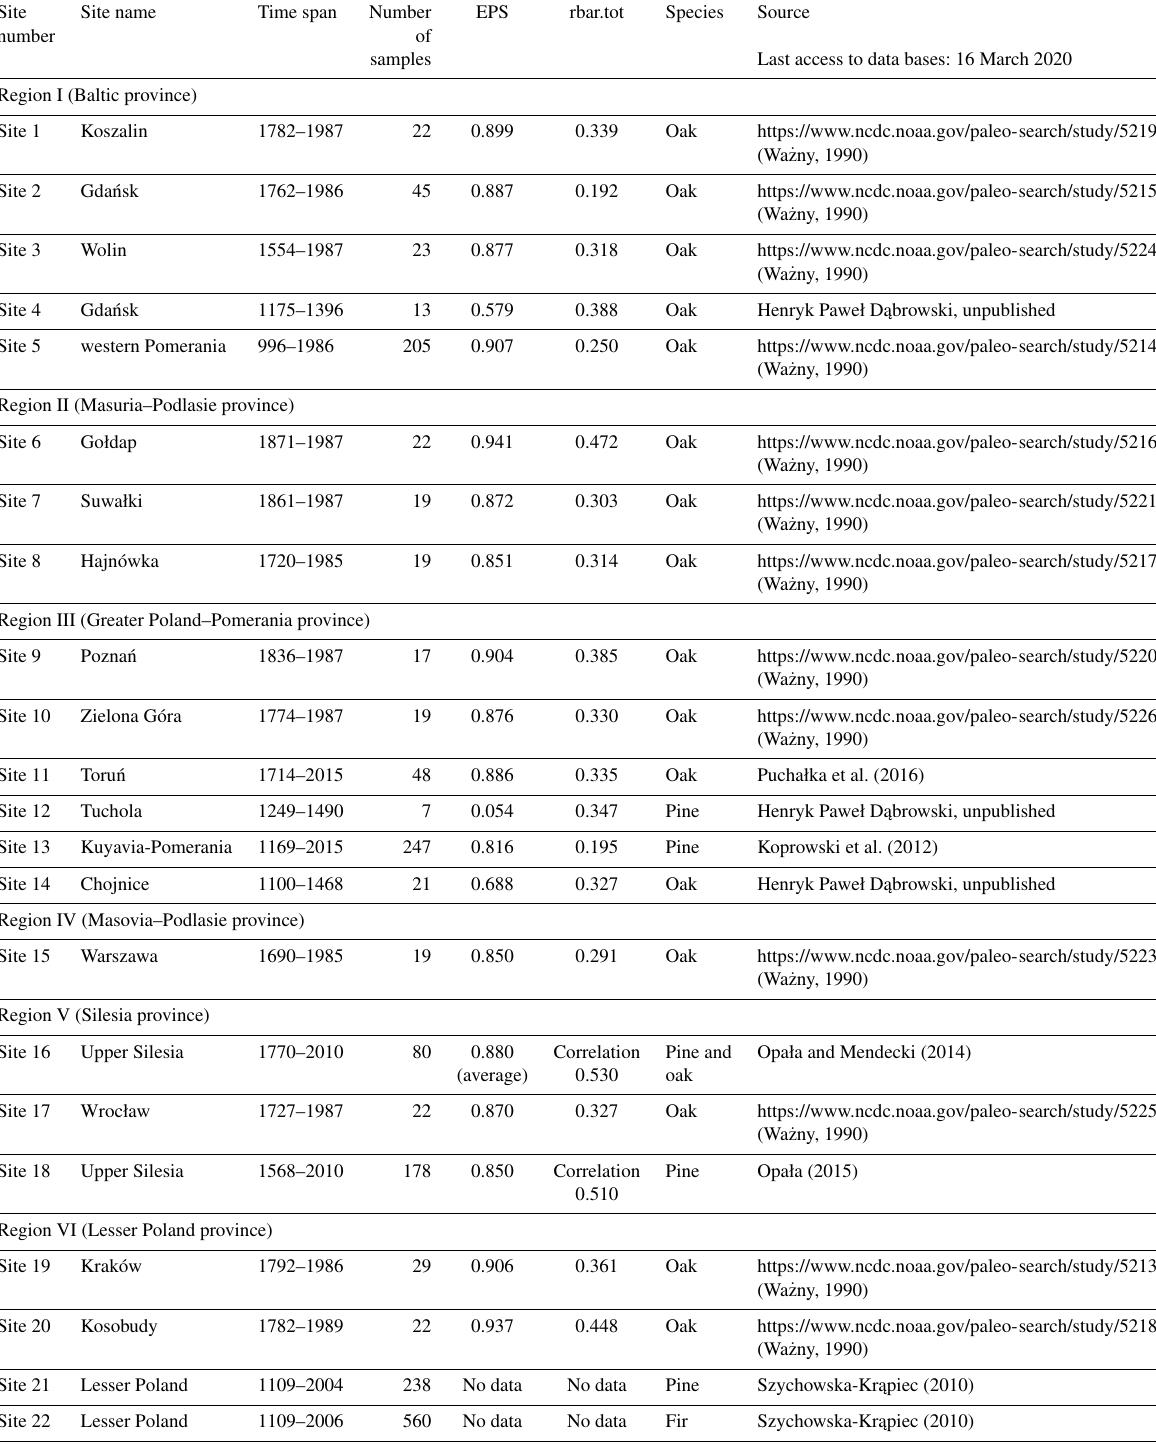
Table 1. Basic characteristics of the chronologies used for pointer year analysis. Locations of natural-forest regions (Zielony and Kliczkowska, 2010) and sites are shown in Fig. 1. EPS – expressed population signal, rbar.tot – the mean of all correlations between different